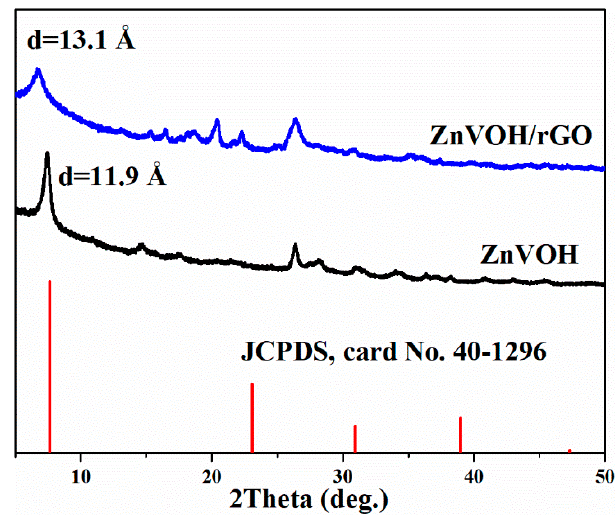
Figure 1. XRD patterns of ZnVOH and ZnVOH/rGO.